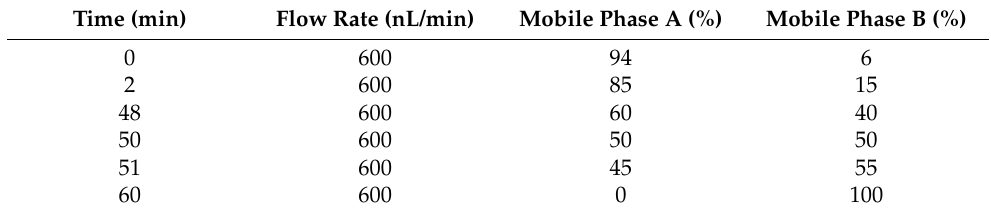
Table 2. Liquid chromatography elution gradient